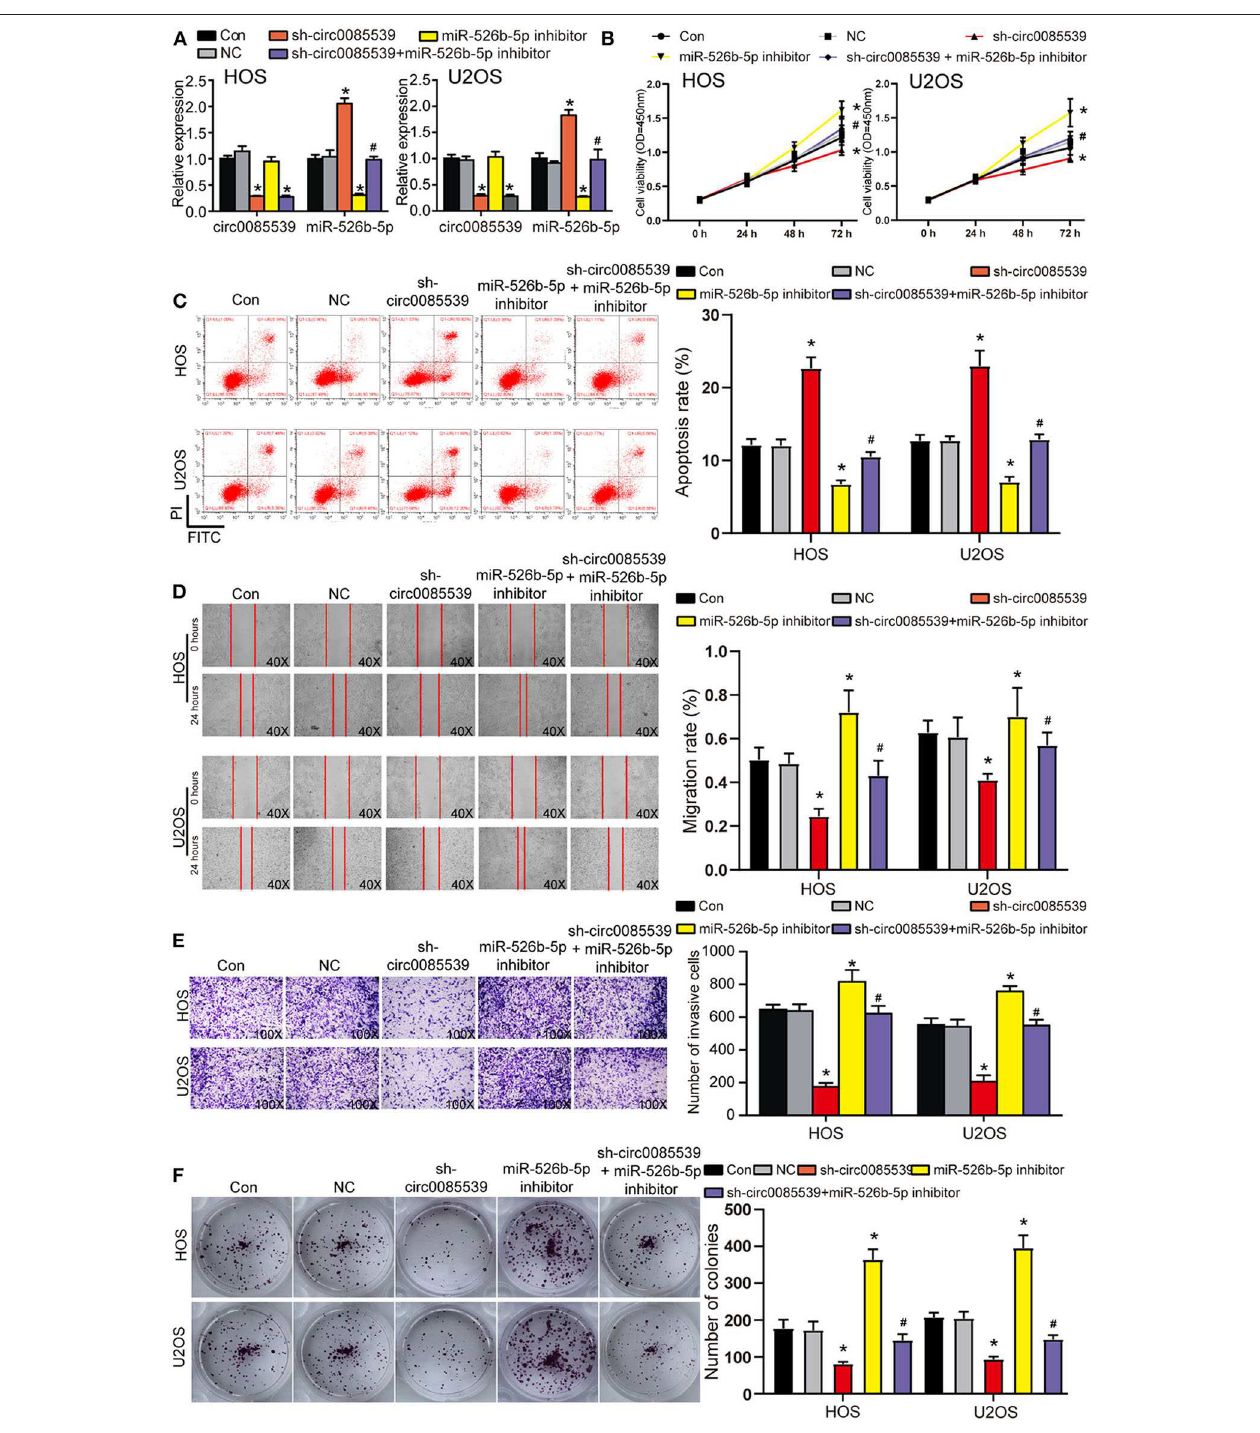
FIGURE 4 | Silence of circ0085539 increased cell apoptosis rate but suppressed the viability, migration, invasion, and proliferation abilities of osteosarcoma (OS) cells in a miR-526b-5p-dependent way. (A) The transfection efficiency of sh-circ0085539 plasmids, miR-526b-5p inhibitor, and sh-circ0085539 + miR-526b-5p inhibitor in HOS and U2OS cells was determined by quantitative reverse transcription PCR (qRT-PCR). (B) The cell viability of OS cells in the five groups was analyzed by CCK8 assay. (C) The apoptosis rate of OS cells in the five groups was analyzed by flow cytometry analysis. (D) The migration ability of OS cells in the five groups was analyzed by wound healing assay. Magnification: 40 × . (E) The invasion ability of OS cells in the five groups was analyzed by Transwell assay. Magnification: 100 × . (F) The colony formation ability of OS cells in the five groups was analyzed by colony formation assay. Con, control; NC, negative control. * p < 0.05 vs. control. # p < 0.05 vs. sh-circ0085539